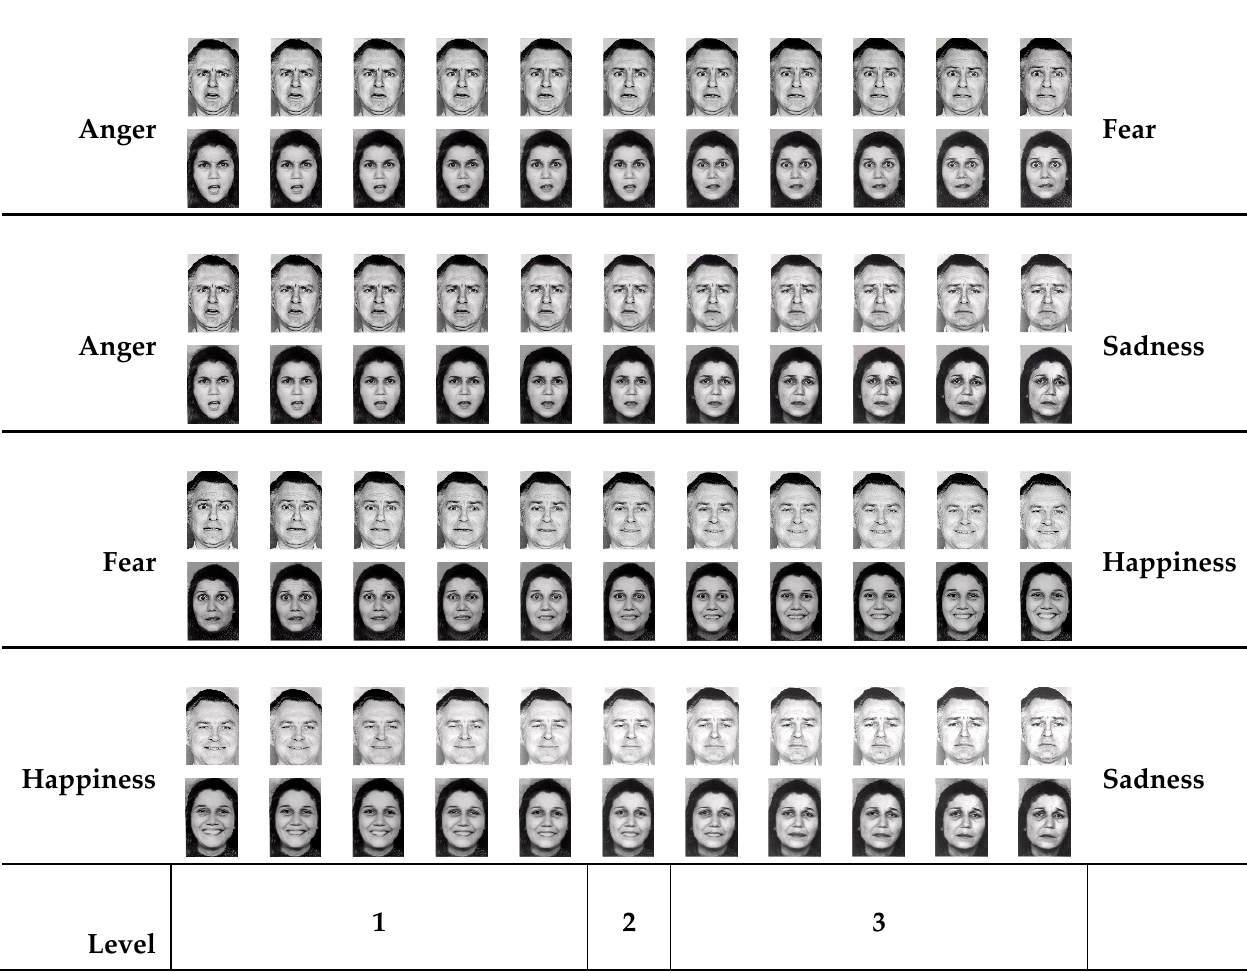
Figure 1. The 88 stimuli used in the facial expression categorization test, separated for each contin- uum.